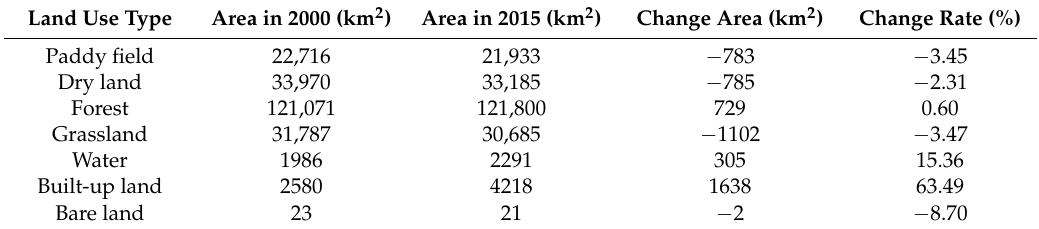
Table 4. Land use characteristic of the Guizhou and Guangxi Karst Mountainous Region in 2000 and 2015.